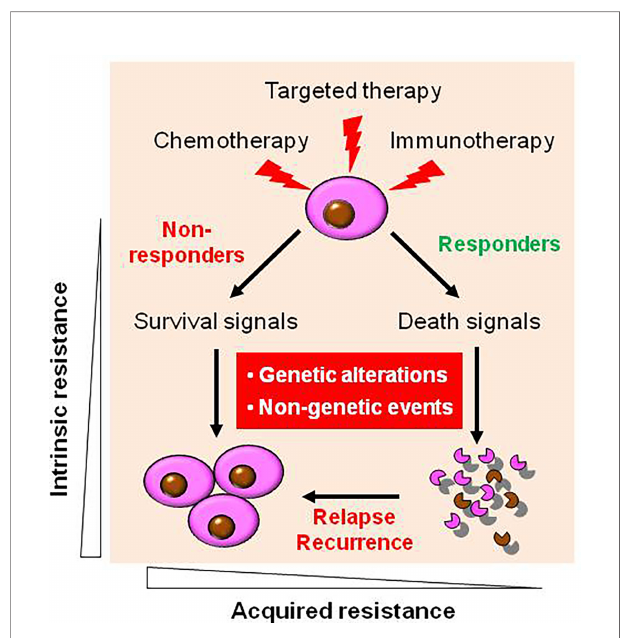
FIGURE 1 | Diverse types of drug resistance to targeted therapy. During targeted therapy as well as conventional chemotherapy and novel immunotherapy, most patients carrying the driver genetic alterations respond to corresponding targeted agents, who are known as responders, while some patients who do not respond well, who are known as non-responder, due to intrinsic (primary) resistance. However, virtually all responders will eventually relapse and become resistant to agents targeting the original oncoproteins (as well as other targeted agents in most cases) due to acquired (secondary) resistance. Mechanistically, both intrinsic and acquired resistance stem from either genetic (e.g., de novo mutations) or non-genetic mechanisms, or